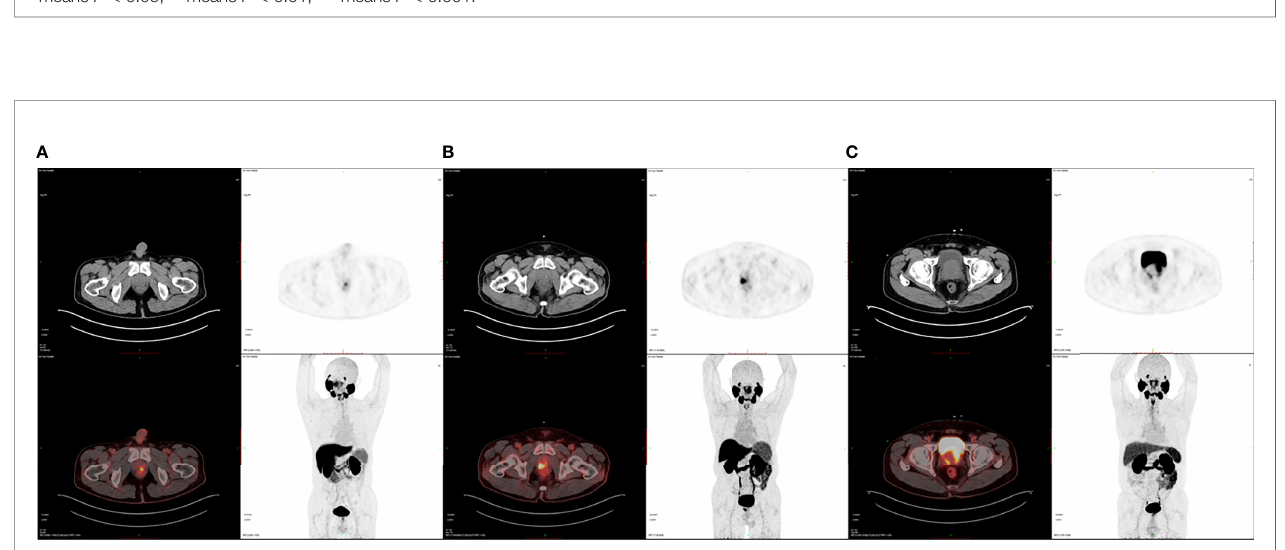
FIGURE 2 | Representative 18 F-DCFPyL PET/CT images of PCa patients at various risks. (A) SUVmax is 4.04 and the P/M ratio is 10.12 in a low-risk PCa patient. (B) SUVmax is 10.61 and the P/M ratio is 35.36 in an intermediate-risk PCa patient. (C) SUVmax is 30.94 and the P/M ratio is 91.26 in a high-risk PCa